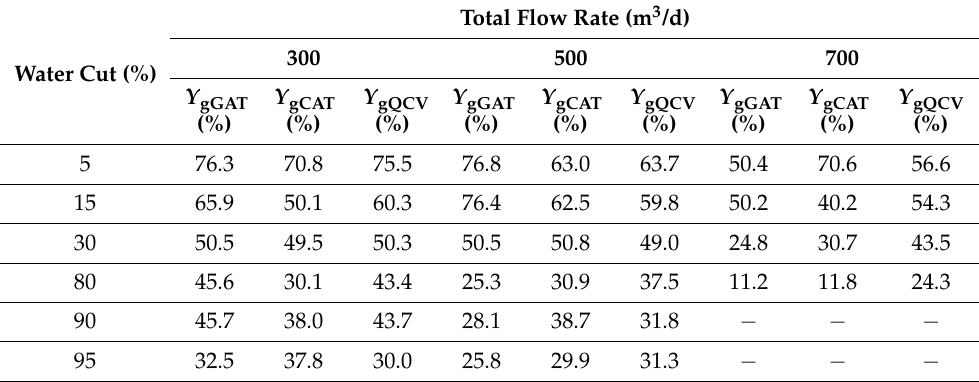
Figure 8. Comparison of GAT and CAT interpolation imaging under different measurement condi- tions after projection. Table 3. Comparison of gas holdup of GAT, CAT, and quick-closing-valve (QCV).